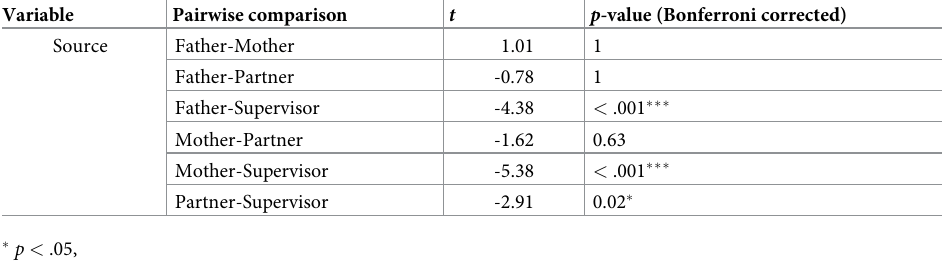
Table 5. Pairwise comparisons of levels of relational distancing by source for high and low perceived criticism